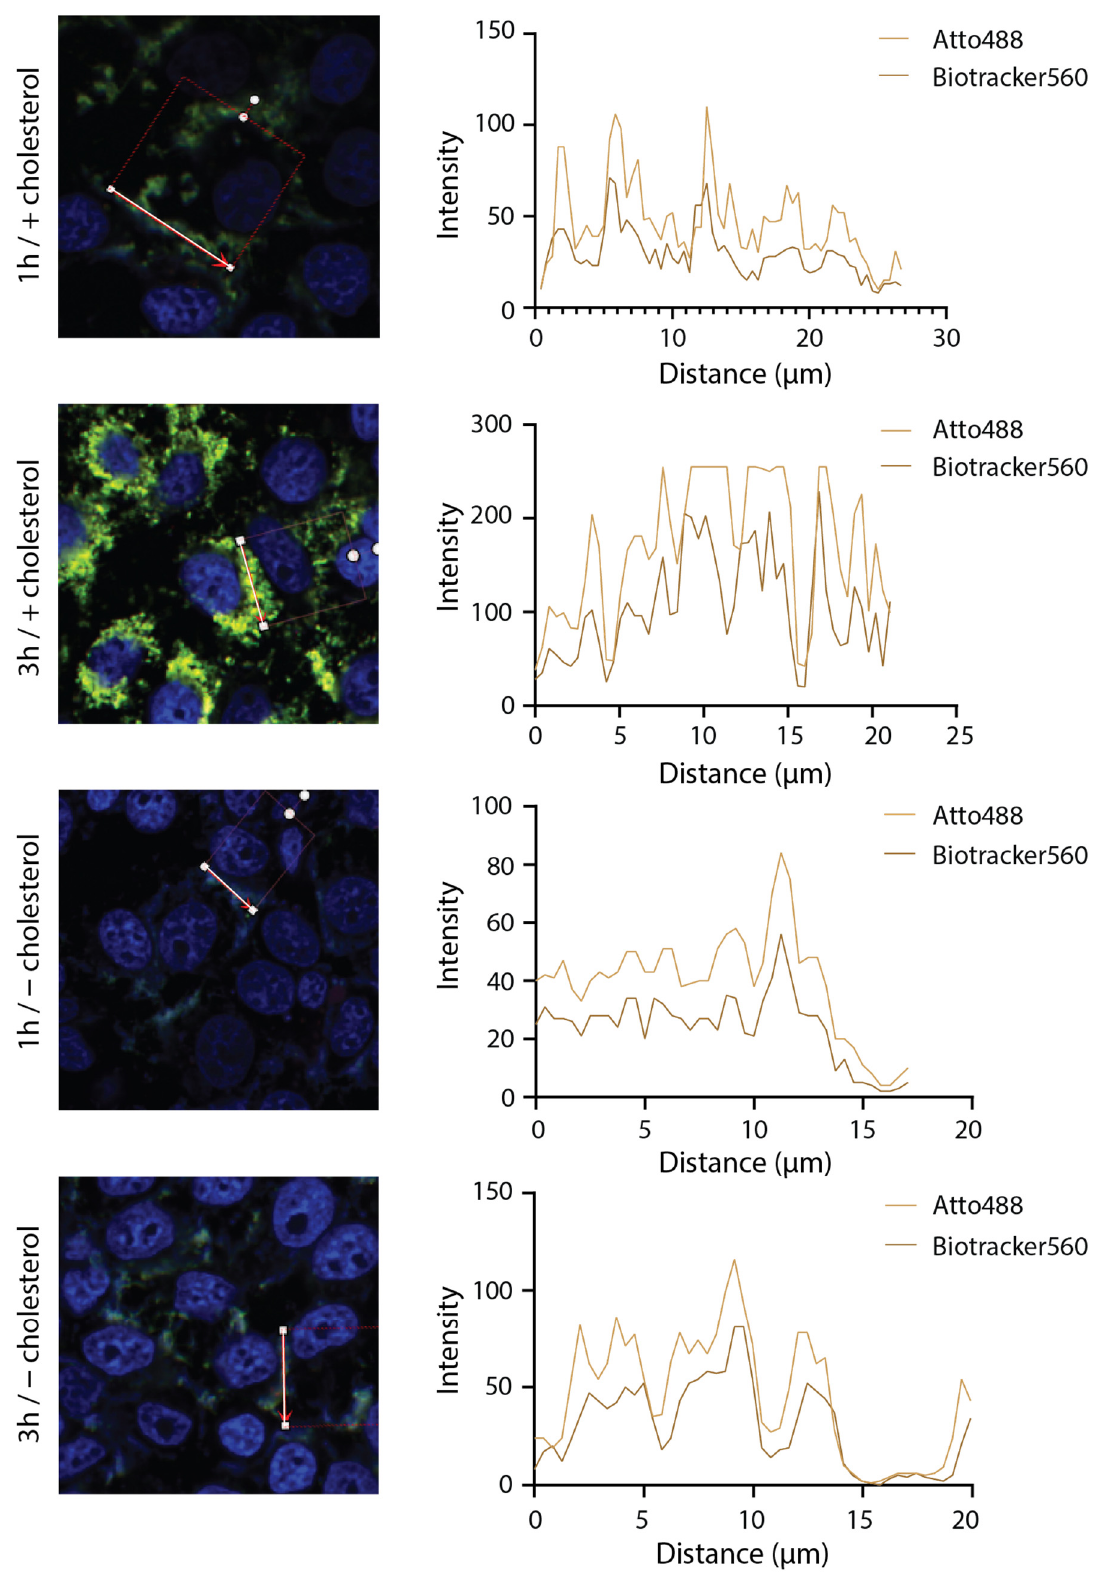
Figure A3. Fluorescent intensity profile analysis of cells incubated with Atto488 labelled cytochrome c (green) and Biotracker560 (red) along the arrowed lines.